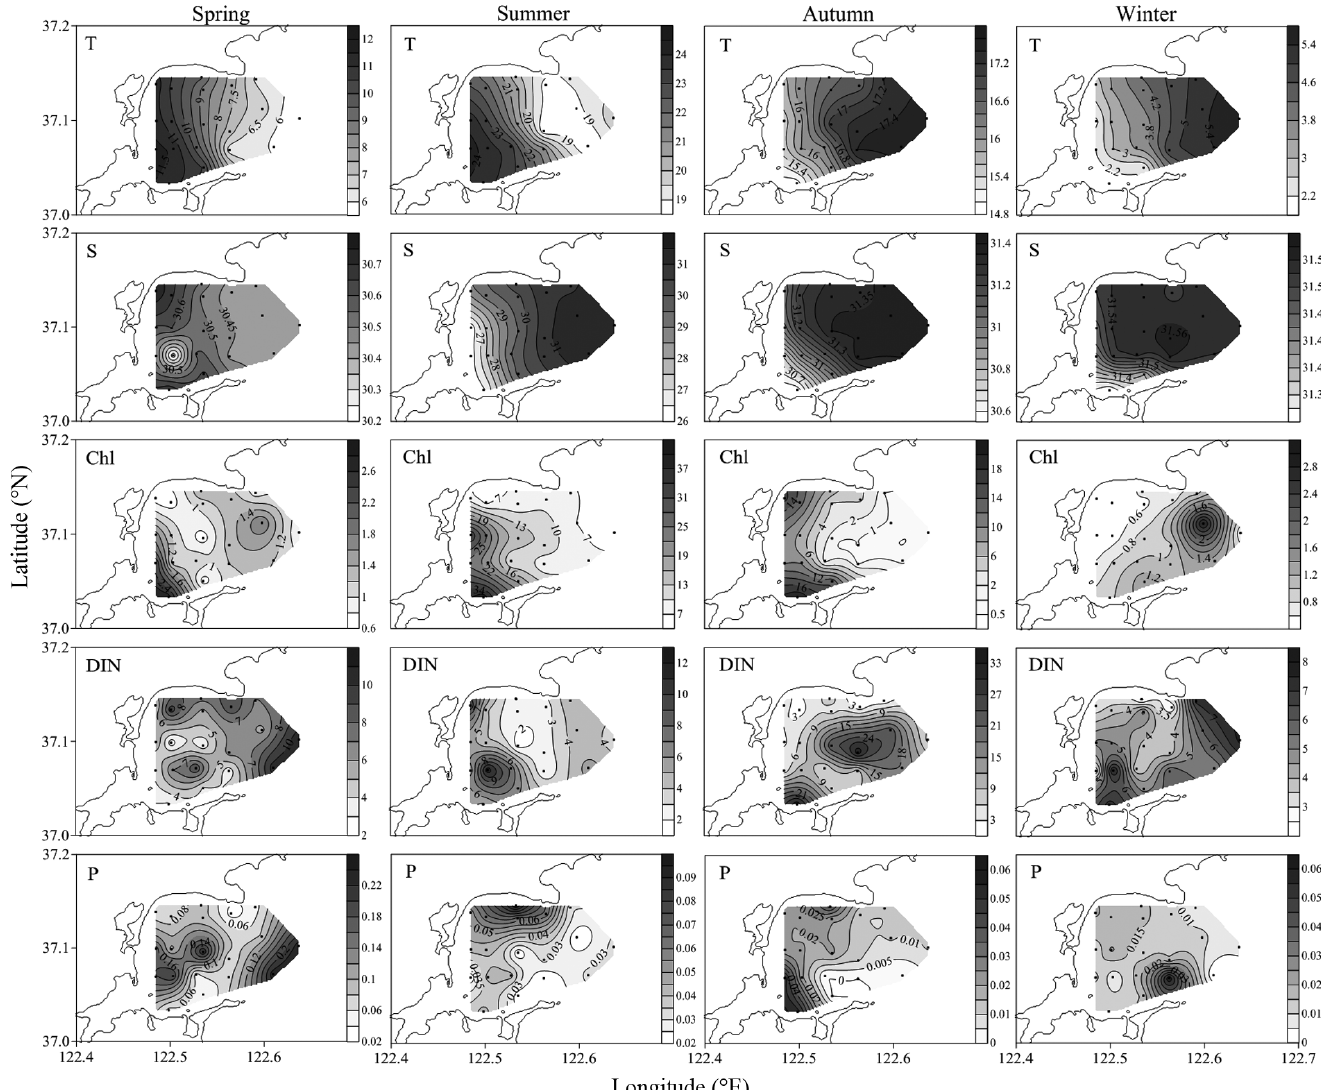
Fig. 2. Spatial distribution of environmental variables in Sanggou Bay and adjacent area over 4 successive seasons. Black dots: sampling stations; T: temperature (°C); S: salinity; Chl: chl a concentration (mg m −3 ); DIN: dissolved inorganic nitrogen (repre- sents the sum of NO 3 − , NO 2 − and NH 4+ , µM); P: PO 43 −